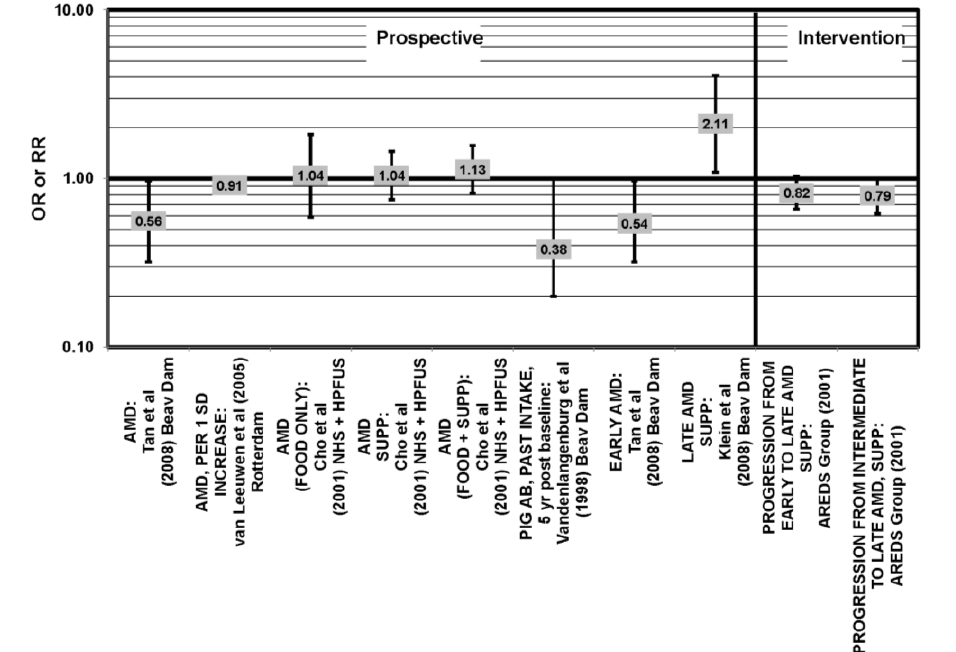
Figure 39. Odds or risk ratio for AMD, early AMD or late AMD; high vs. low intake (with or without supplements) of zinc: prospective and intervention